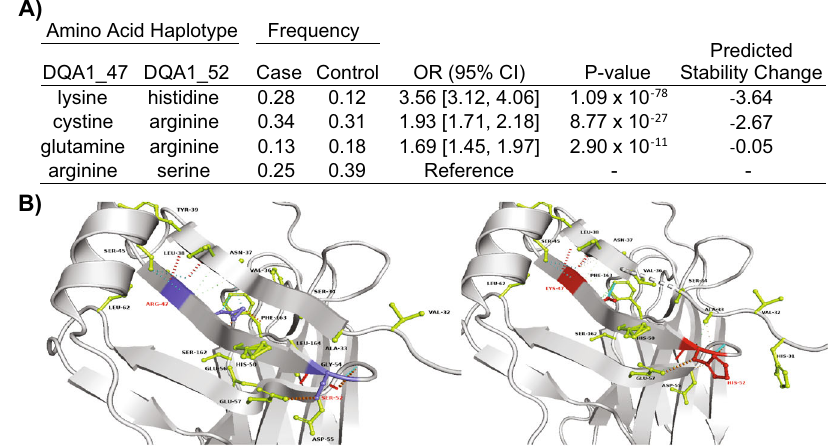
Fig. 4 | HLA-DQA1 amino-acid associations and stabilityprediction. A Increased risk and predicted stability change of the two-amino-acid residue haplotypes at HLA-DQA1 positions47and52.Oddsratiosand P values(two-sided)arefromajoint logistic regression with arginine 47 -serine 52 , the most common, set as reference, adjusting for population-speci fi c principal components and continental popula- tions. The reference haplotype confers the strongest protection (i.e., odds ratios indicate increase in risk compared to arginine 47 -serine 52 ).Decreasing values of the